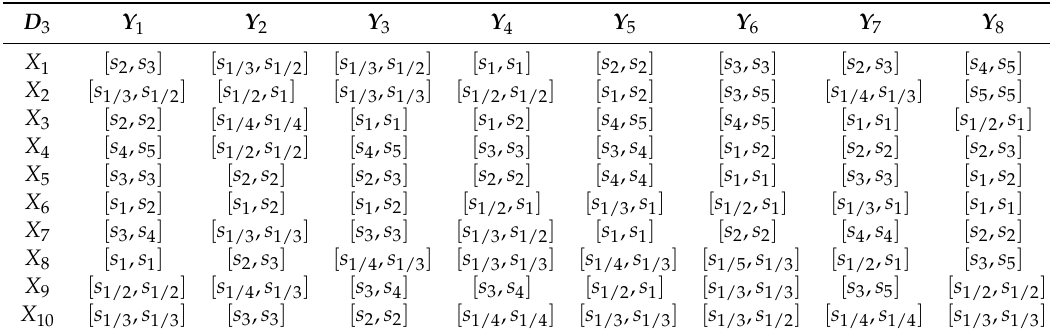
Table A3. Linguistic evaluation information matrix of D 3 .